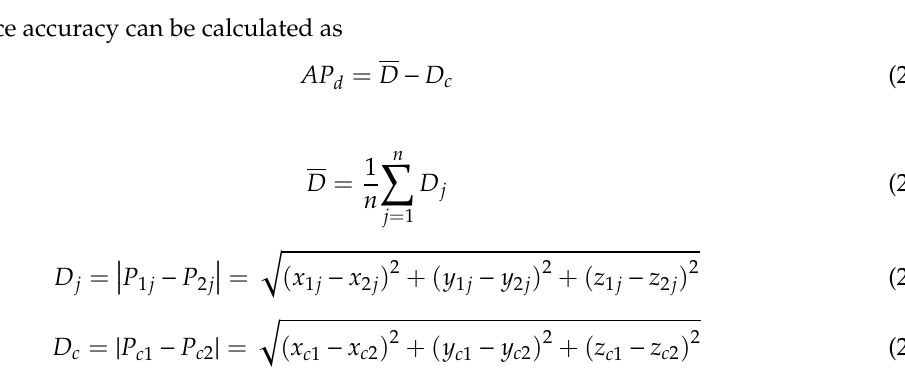
Figure 7. Distance accuracy.